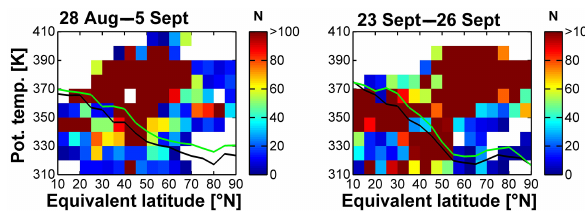
Figure 10. Data coverage (number of data points N in each bin) of TACTS 2012 in potential temperature (cid:50) and equivalent latitude φ eq coordinates. Left: data coverage of the initial phase of TACTS from 28 August to 5 September. Right: data coverage of the final phase of TACTS from 23 to 26 September. The black and green lines denote the location of the dynamical (PV = 2pvu) and thermal tropopause, respectively (WMO,